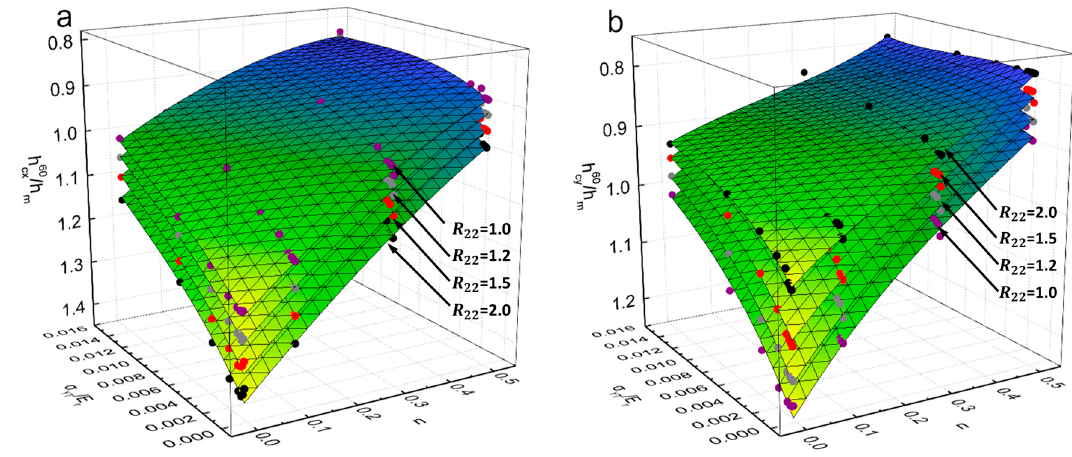
Figure 8. Representative fitting surfaces of dimensionless functions: ( a ) Π (cid:2871)(cid:2874)(cid:2868) ; ( b ) Π (cid:2872)(cid:2874)(cid:2868) .